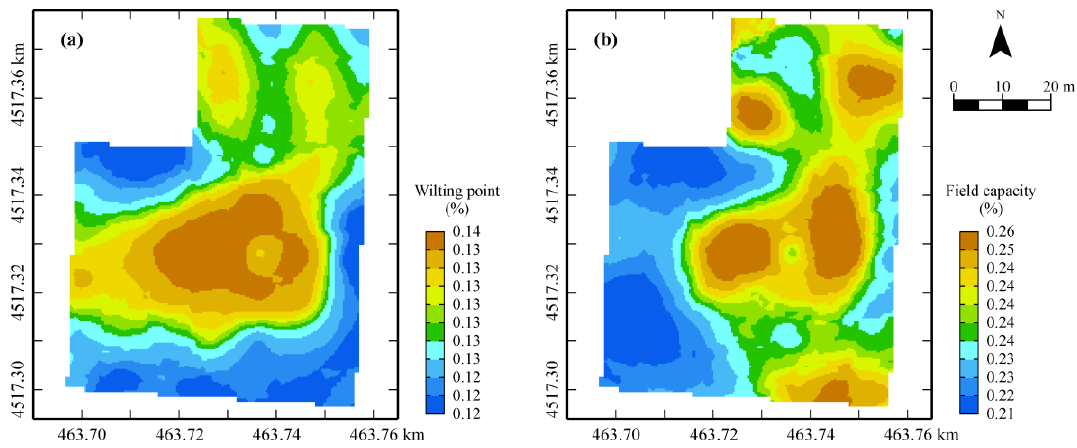
Figure 9. Cokriged maps of wilting point ( a ) and field capacity ( b ).